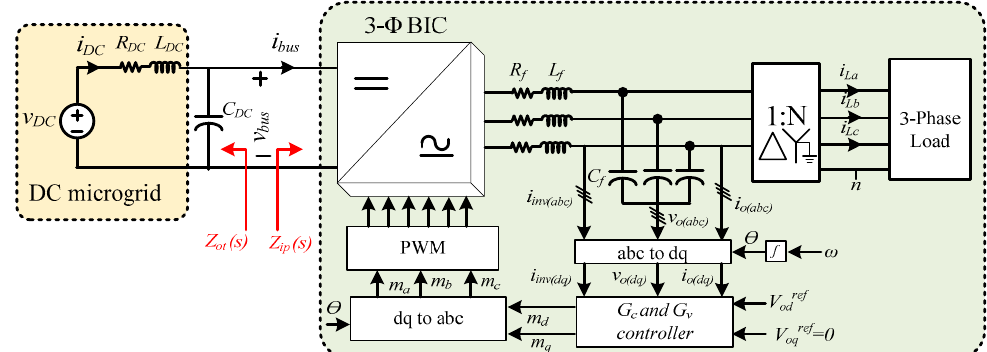
Figure 15. Cascaded system given in [95].